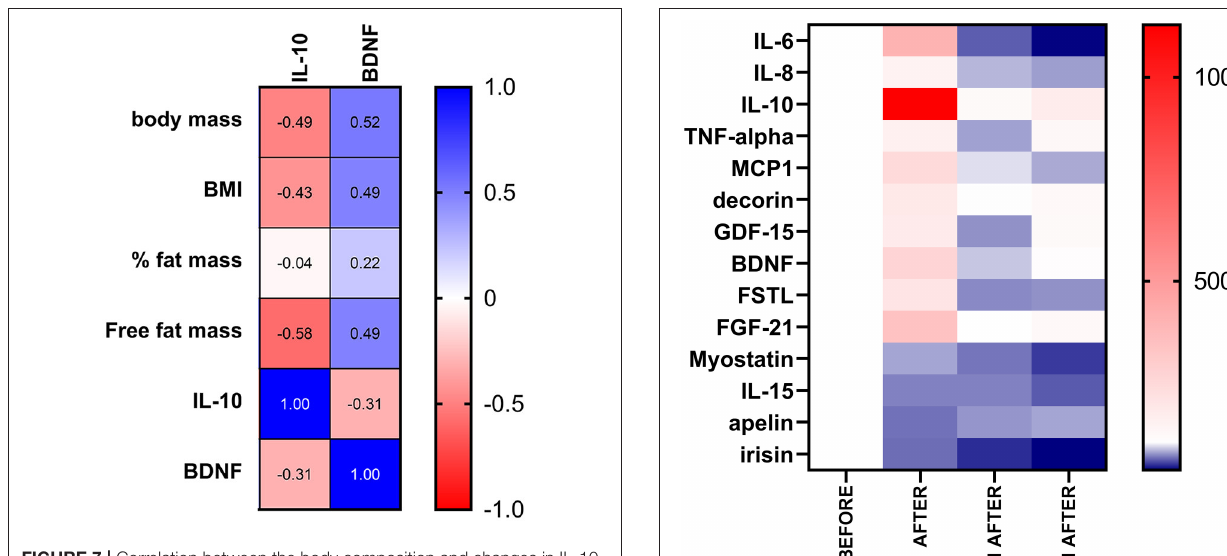
FIGURE 7 | Correlation between the body composition and changes in IL-10 and BDNF after the race. The values are presented as Spearman’s r of 43 runners for IL-10 and 38 runners for BDNF. Colormap with range between 1 and − 1 and blue for the largest value and red for the smallest value.